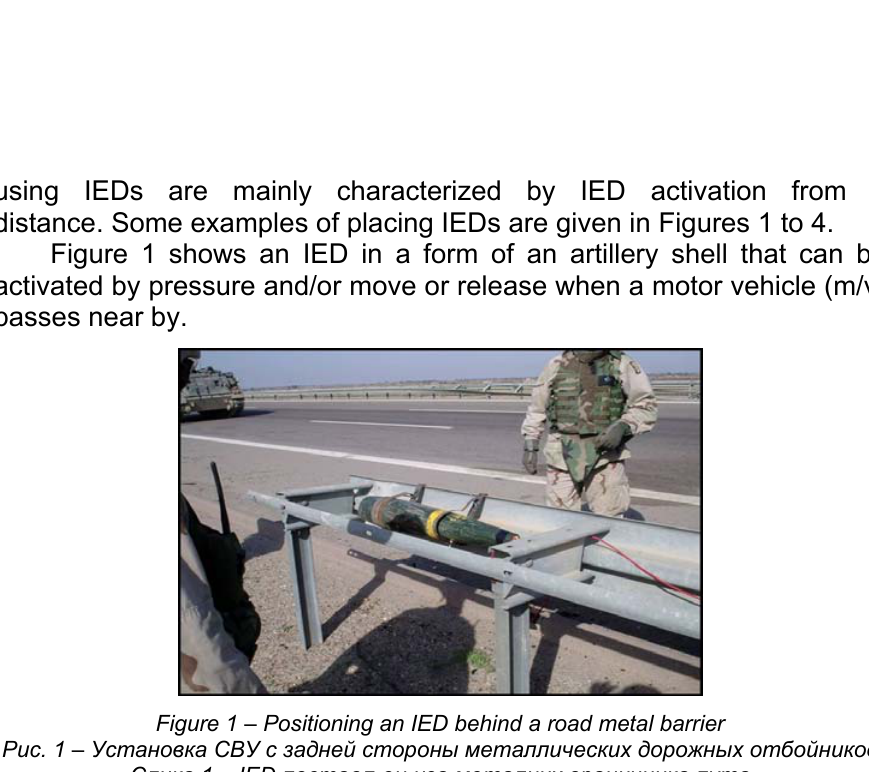
Рис . 1 – Установка СВУ с задней стороны металлических дорожных отбойников